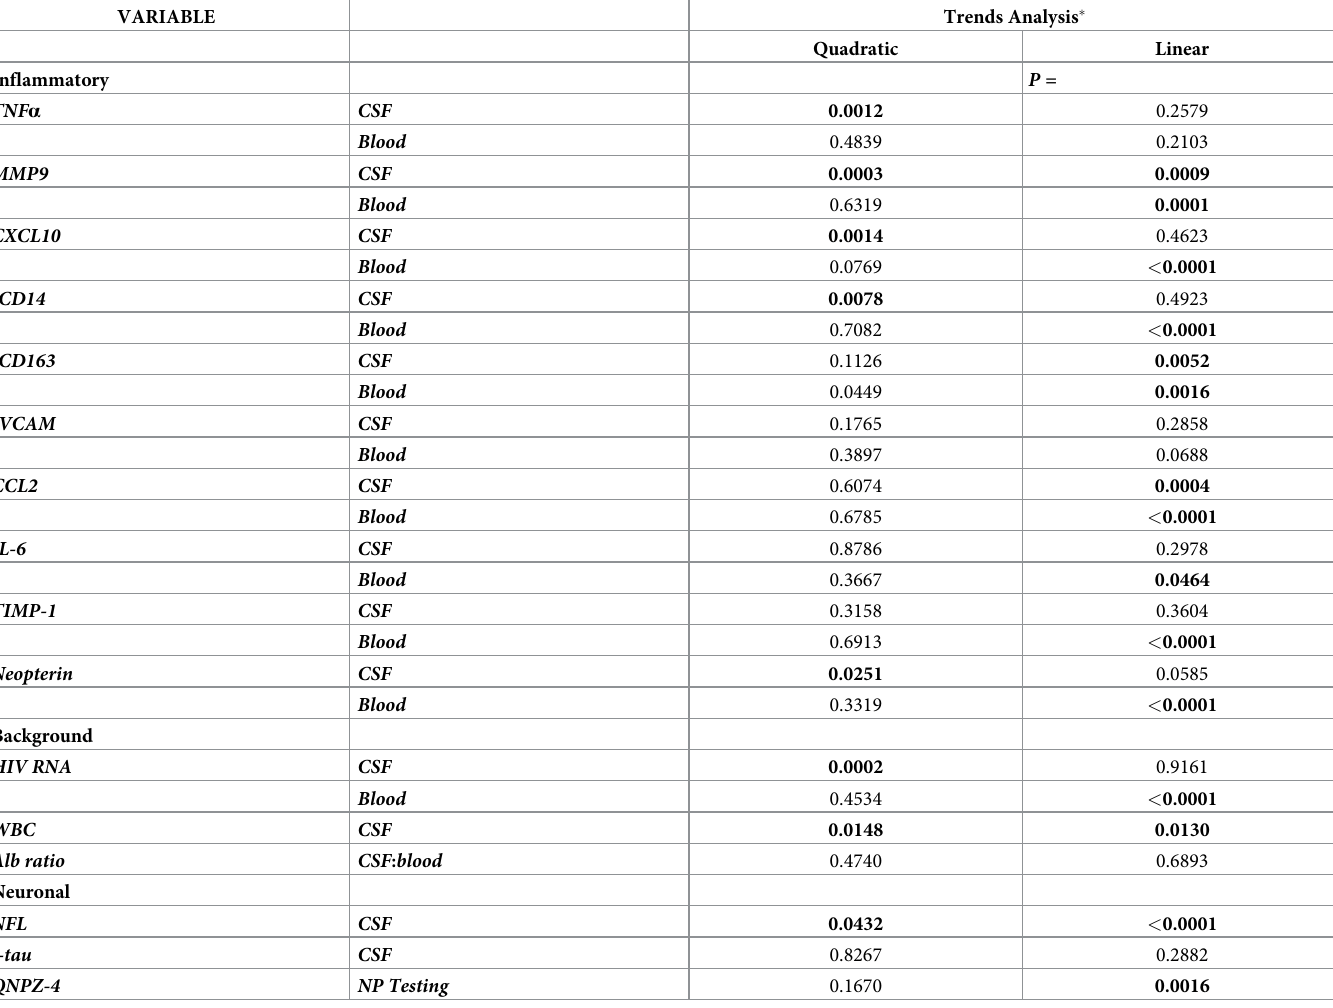
Table 4. Analysis of trends in the four groups of untreated without HAD. The table list the P values solving for quadratic and linear trends for the CSF and blood inflammatory biomarkers and selected background biomarkers over the 4 subject groups defined by blood CD4+ T cell counts shown in Fig 4 .